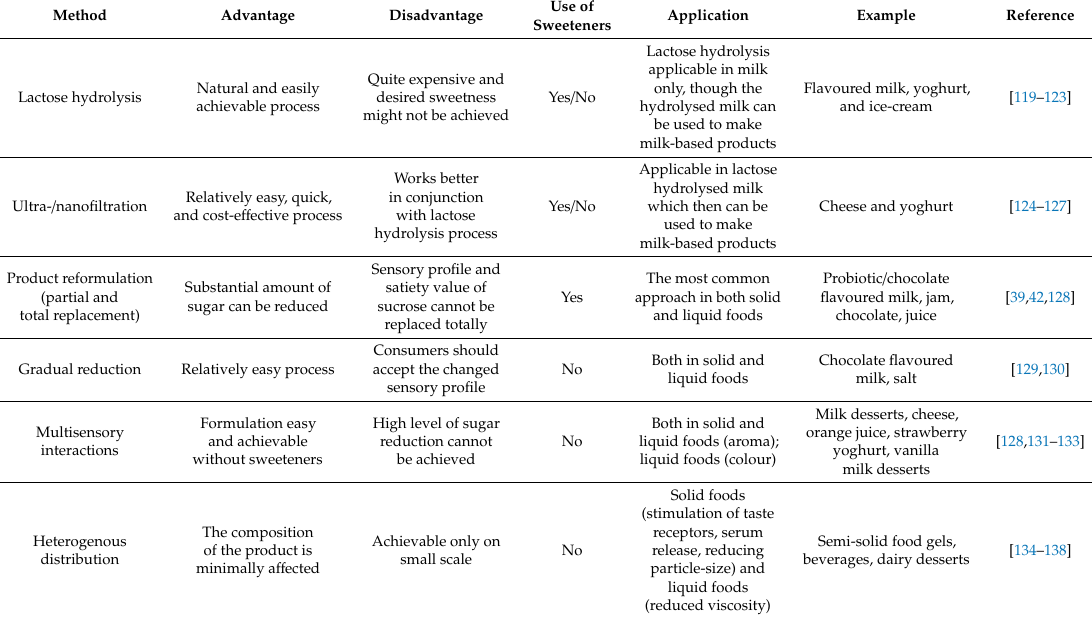
Table 3. Sugar reduction strategies, feasibility, and their applications in milk-based products and other